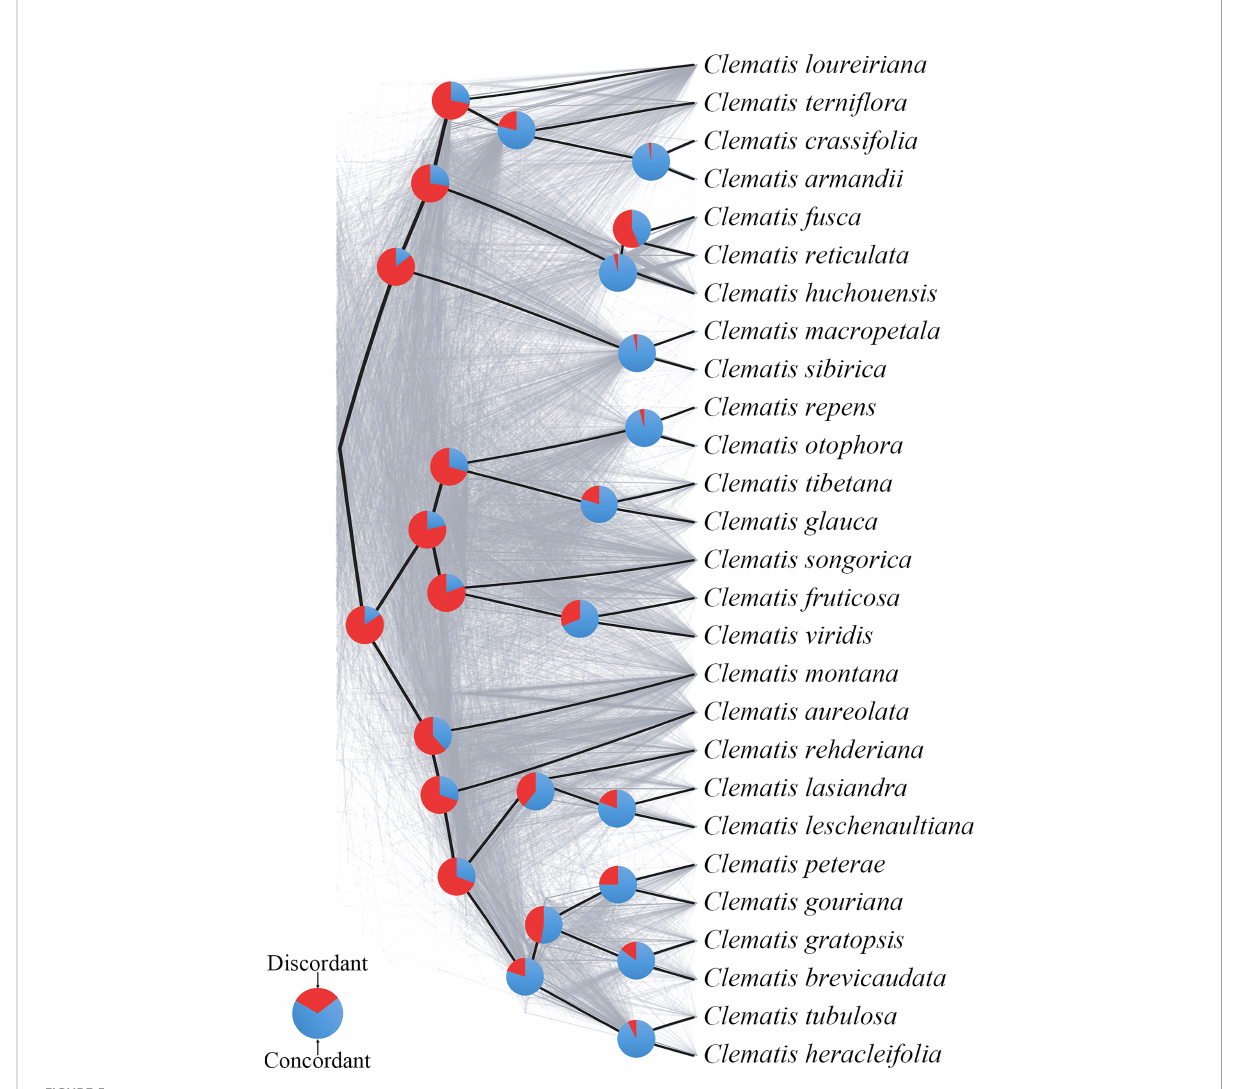
FIGURE 5 A cloud tree showing discordance among nuclear genes. The ASTRAL species tree (based on trees from SCOG1000 dataset with average bootstrap value more than 60) is in heavy black lines. All the branches are fully supported. The gray-colored trees (cloud tree) were sampled from 695 SCOGs (without missing taxa). Pie charts show the proportions of concordant and discordant topologies of gene trees comparing to the species